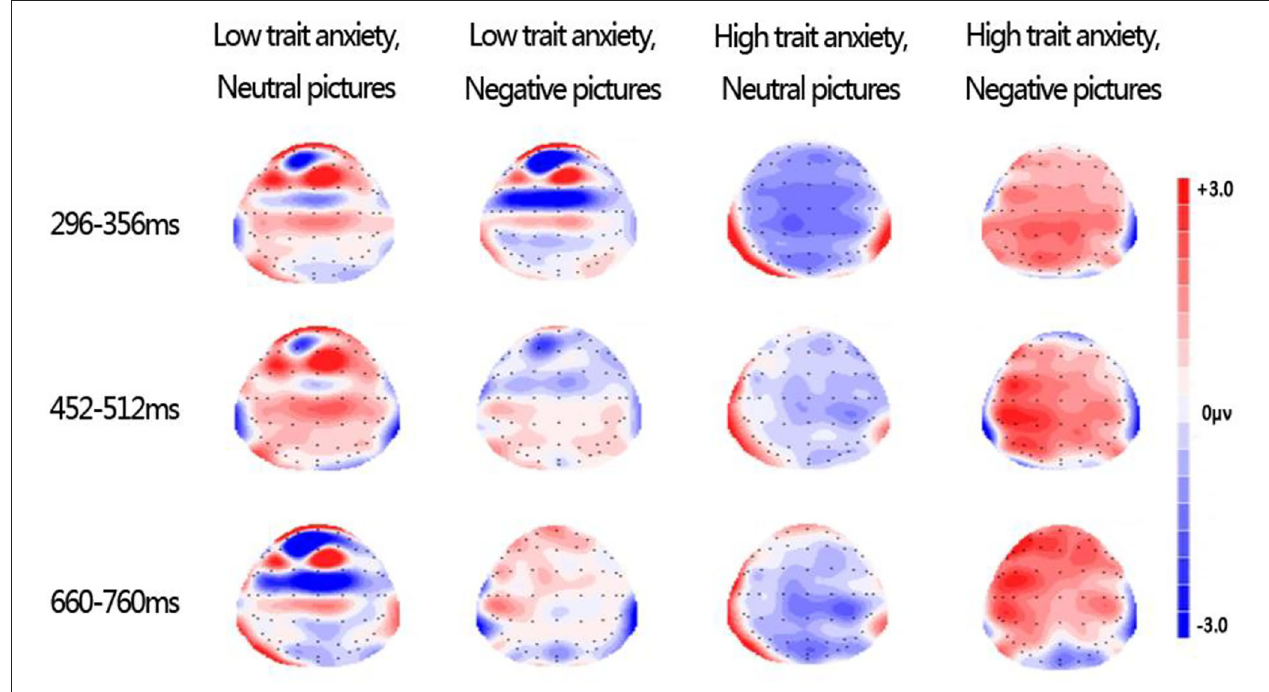
FIGURE 3 | Topographies of difference waves formed by subtracting spatial trial ERPs from verbal trial ERPs during 296–356, 452–512, and 660–760ms after picture